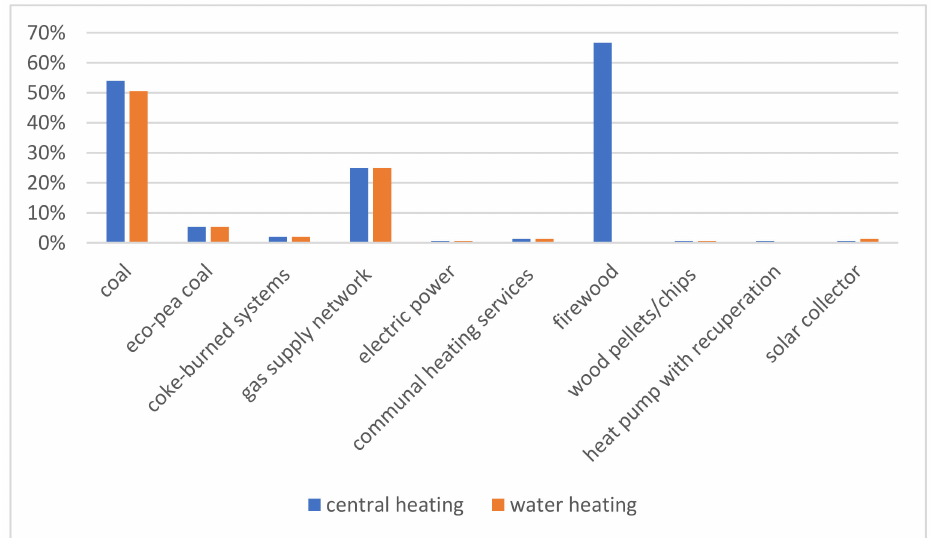
Figure 4. The source of central and water heating in homo energeticus